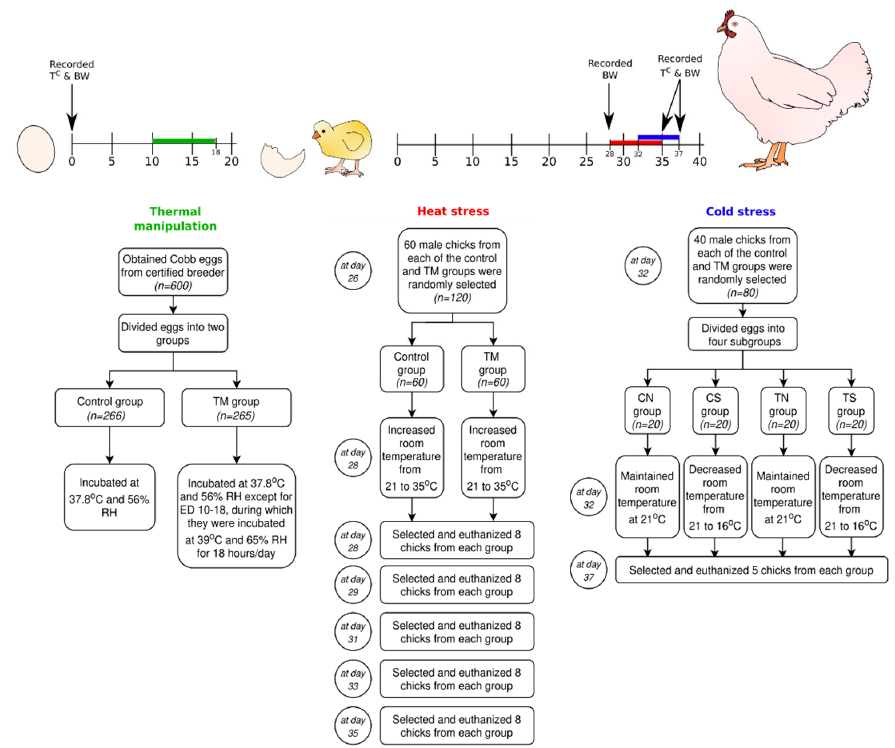
Figure 1. Experimental design showing the three main phases: thermal manipulation, heat stress, and cold stress.